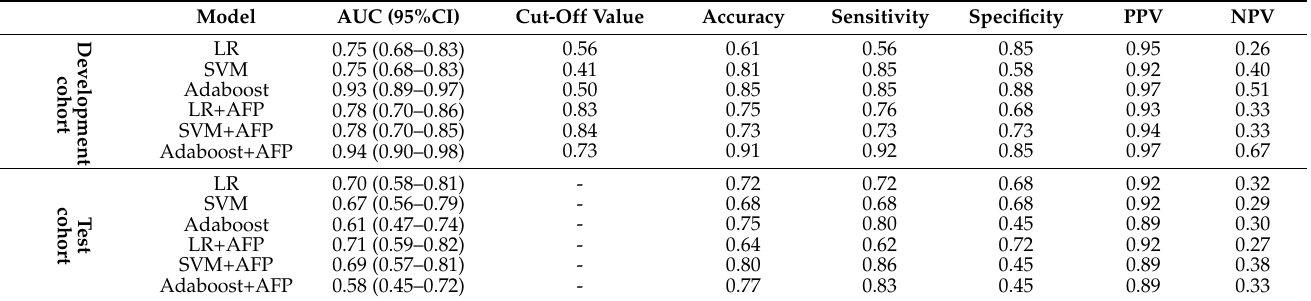
Figure 4. Predictive performance of the logistic regression radiomics model combined with alpha- fetoprotein (AFP) model at the model development cohort and the test cohort. ( A ) The combined model yielded an Area Under the Receiver Operating Characteristic curve of 0.78 in the development cohort and 0.71 in the test cohort. The calibration curve showed a good agreement between the combined model predicted probability and the actual probability in the development cohort ( B ) and the test cohort ( C ). Table 3. Summary of the model performance in the development and test